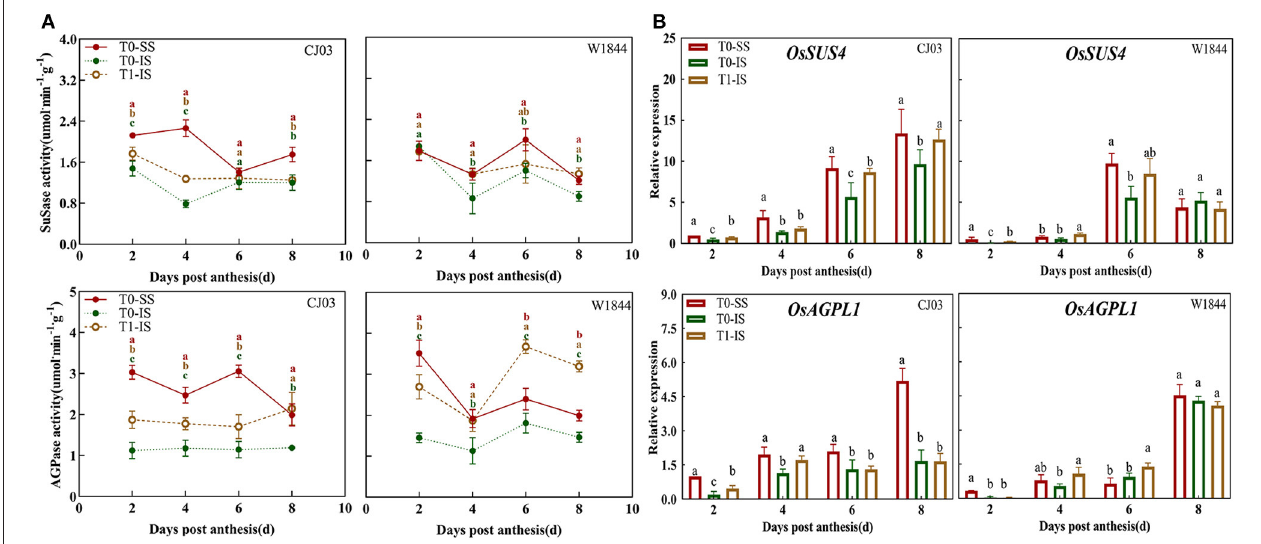
FIGURE 7 | Difference of key enzymes and gene expression involved in of Sucrose to Starch in developing grains of CJ03 and W1844 under spikelet-removing treatments. The T0-control group without any treatment; T1- top 2/3 of the spikelets were removed. Red, green, and yellow bars represent the SS of the T0 group, the IS of the T0 group, and the IS of the T1 group. (A) , the activity of SuSase and AGPase in developing grains at the initiation stage of grain-filling. (B) , the expression of OsSUS4 and OsAGPL1 were validated by RT-PCR. Colored letters indicate statistically significant differences at the P = 0.05